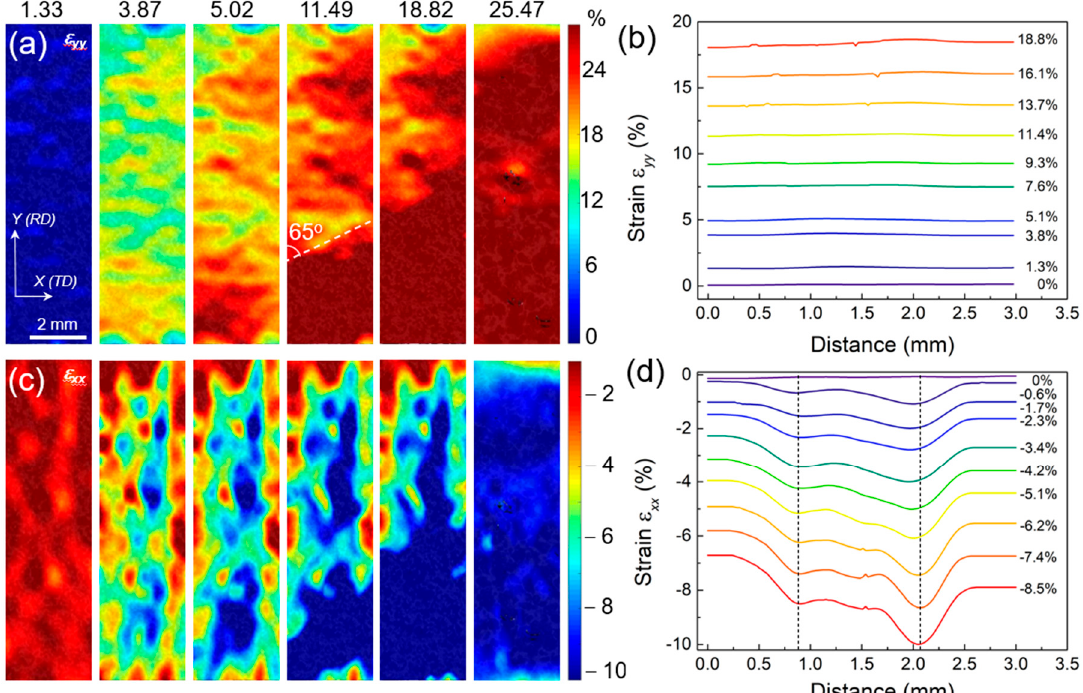
Figure 12. ( a , c ) are the contours of strain ε yy and ε xx mapped at different tensile strains, respectively. ( b , d ) are the distribution of statistical average strain ε yy and ε xx plotted as a function of distance from the width, respectively. The dotted lines mark the position of layer boundaries.